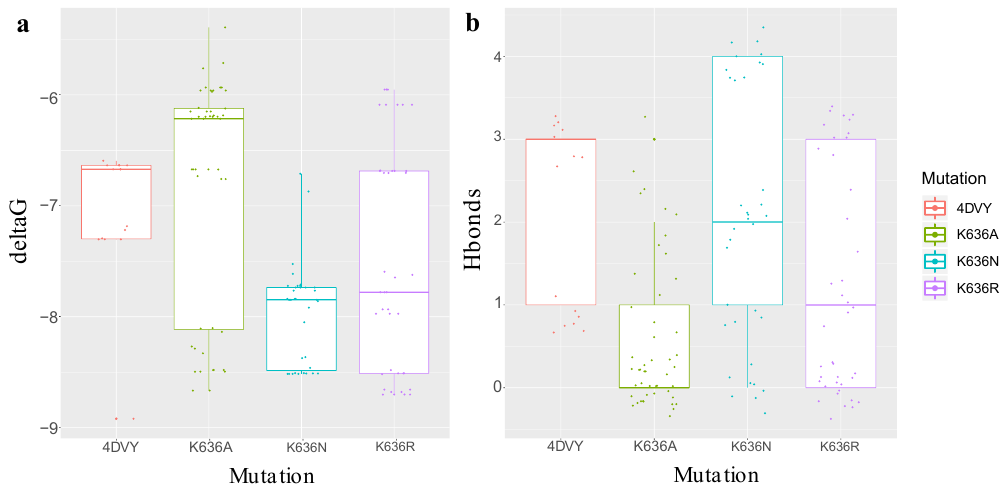
Figure 7. Boxplot comparing overall the Docking results: ( a ) ∆ G values (kcal/mol) for each mutation; and ( b ) Hydrogen Count for each mutation. The median, interquartile range and maximum and minimum values are shown for each boxplot. Data points for each mutation are also